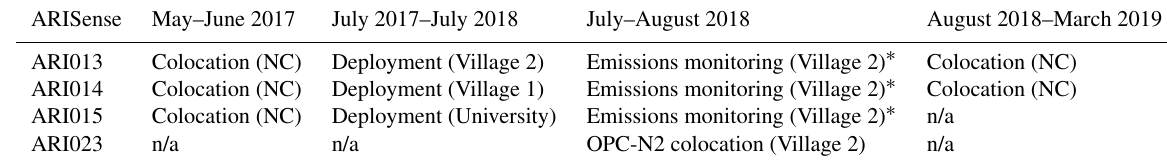
Table 2. Project timeline of colocations, deployment, and emissions monitoring experiments. The description under each period indicates the activity conducted during that timeframe. The location of the activity is given in parentheses.